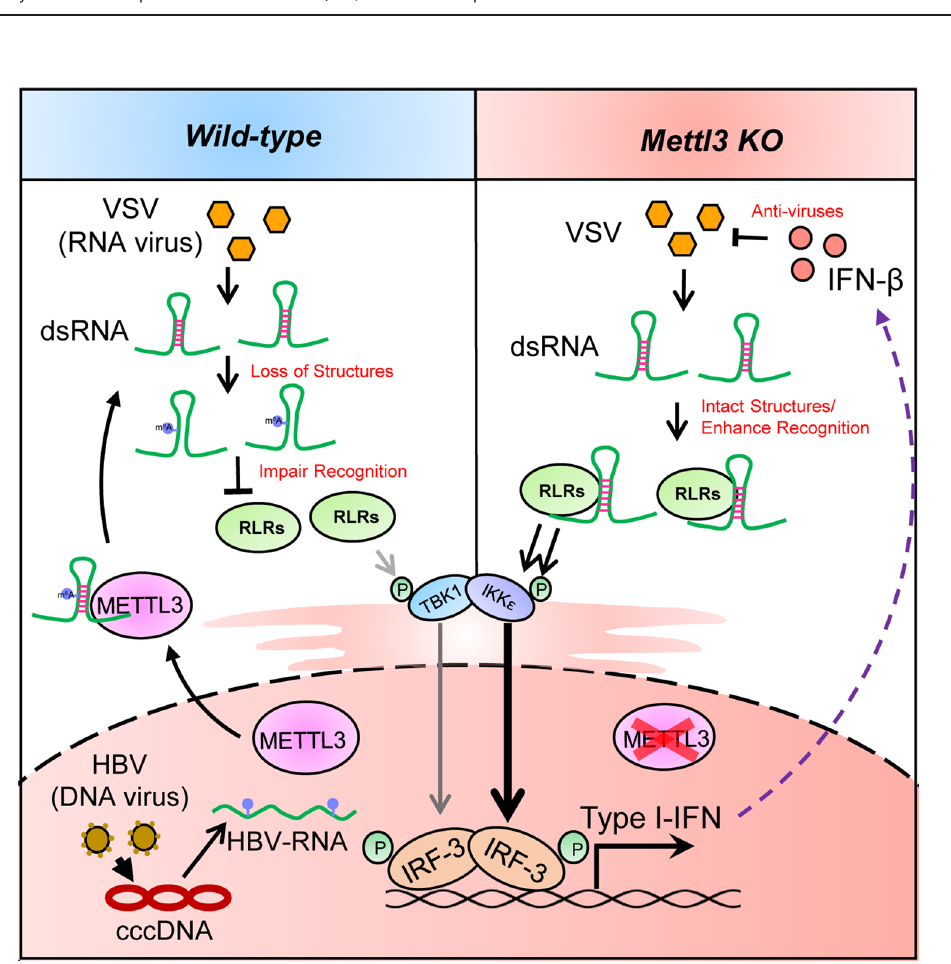
Fig. 7 Model for METTL3-mediated m 6 A modi fi cation dampening viral RNA secondary structure to avoid innate immunity sensing. In the proposed model, VSV RNA contains dsRNA structures to initiate innate immune sensing. During the VSV infection, METTL3 can be attracted from nucleus to cytoplasm to contact and modify VSV RNA. This m 6 A modi fi cation impairs the conformation of duplex structures in VSV RNA and interferes the sensing by dsRNA sensors involving RIG-I and MDA5, which attenuates innate immune response and helps virus invasion. When the host is de fi cient for METTL3, there are more dsRNA structures recognizing by RLRs to drive the expression of type I IFNs, following enhances in anti-viral function. However, the